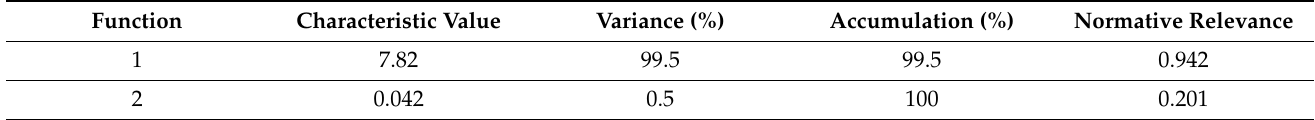
Table 10. Characteristic value results.